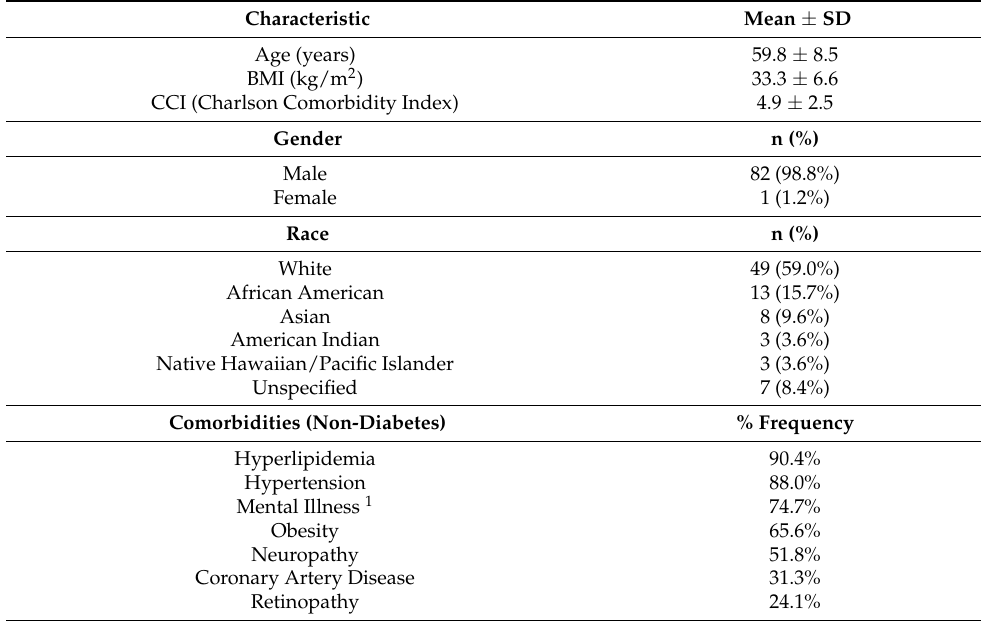
Table 1. Baseline characteristics of all patients included in analysis (n = 83).